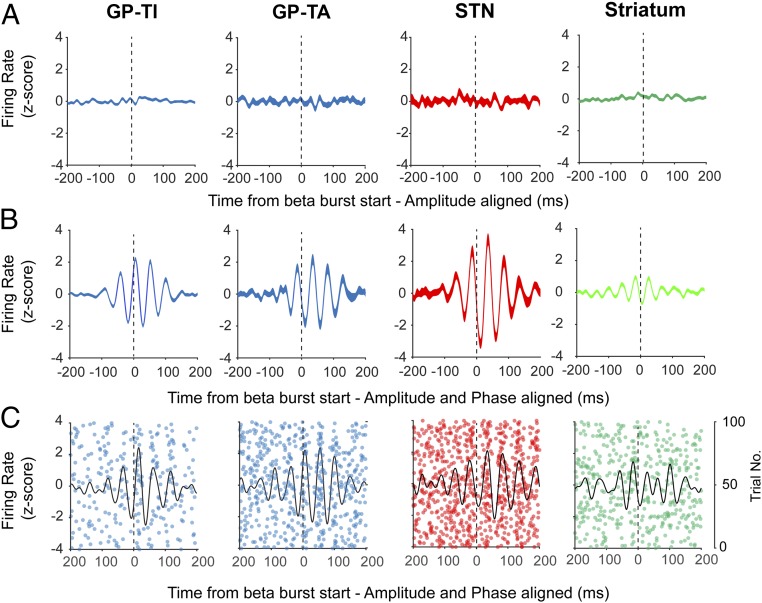
Basal ganglia units transiently phase lock to ECoG β bursts without modulation of firing rate. (A) Mean z-score firing rate of the burst onset-triggered (time 0, 75th percentile of amplitude) single units in each structure, with no adjustment for the cortical beta phase. Firing rate is not altered during the burst. (B) The same analysis but the burst onset trigger is shifted to the nearest peak in the cortical beta phase, aligning the phase of each burst around the trigger. Firing rate is significantly modulated by the phase alignment to the cortical oscillation and offset with respect to time 0. Numbers of units were the same for both analyses (GP-TI = 179, GP-TA = 40, STN = 18, Str = 104). (C) Representative examples of unit activity from the Str, GP-TA, GP-TI, and STN. Each subpanel shows spike timings derived from a single unit, across individual cortical bursts. Black lines indicate the corresponding averaged activity for that unit realigned to the time point that cortical beta amplitude crossed median levels.